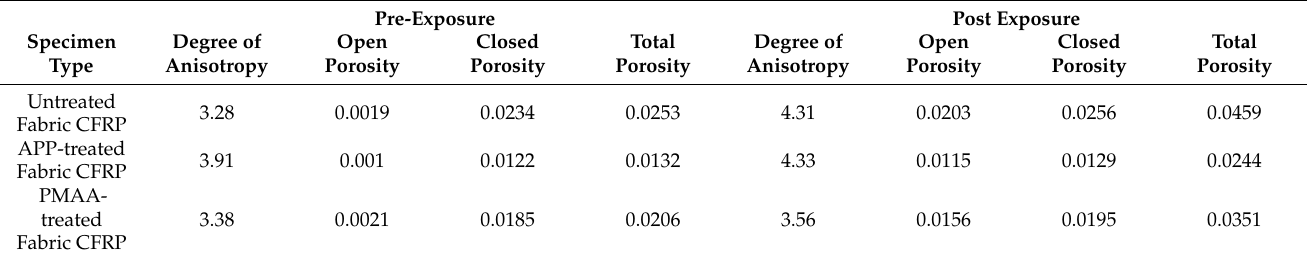
Table 6. Results of 3D analysis performed by m-CT.